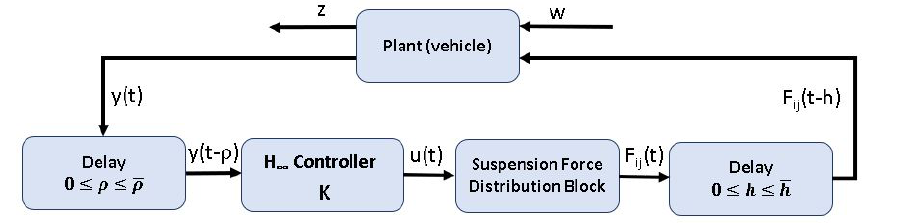
Figure 2. Control block diagram.